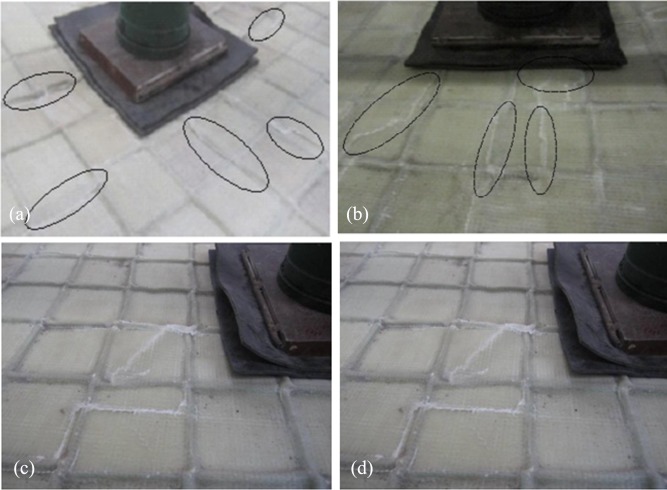
Fracture failure of the upper face sheet.(a) SX50-75. (b) SX75-75. (c) SX100-75. (d) SX75-125.